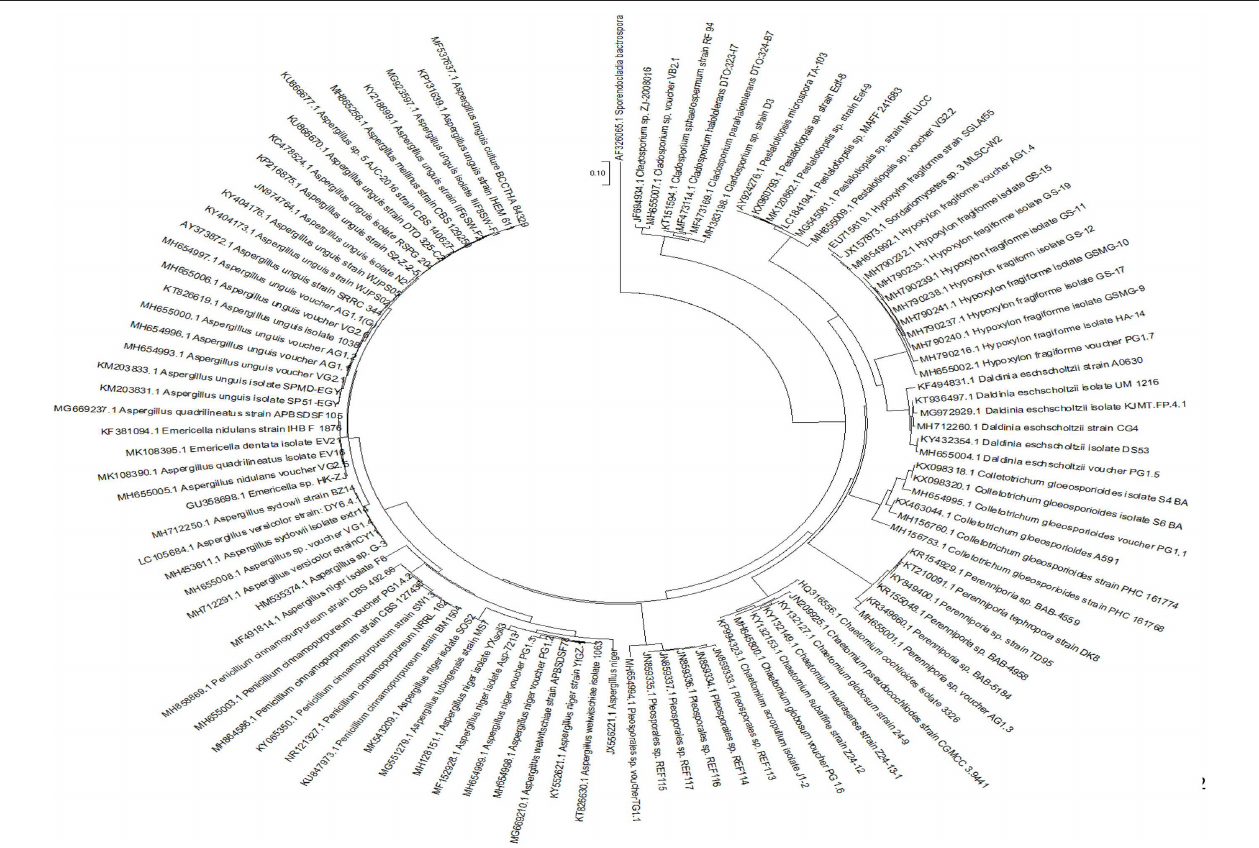
FIGURE 2 | Phylogenetic tree based on neighbor-joining method. The tree was constructed using ITS-region sequences of fungal endophytes isolated from marine algae.